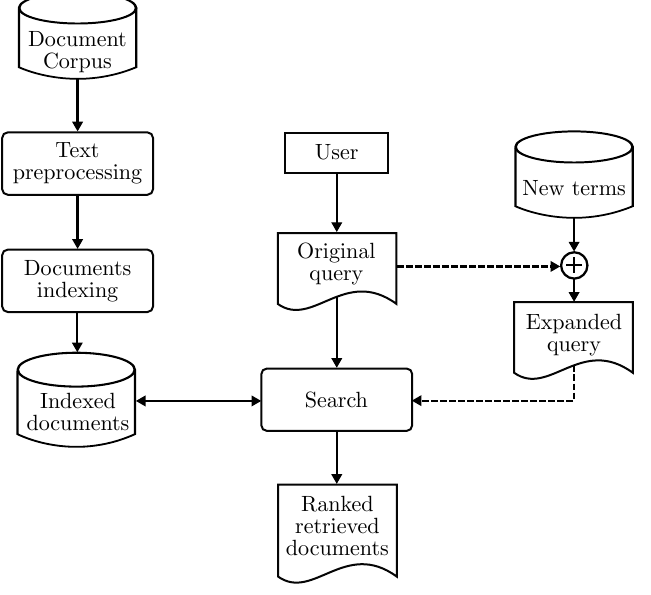
Figure 1. Information retrieval—general